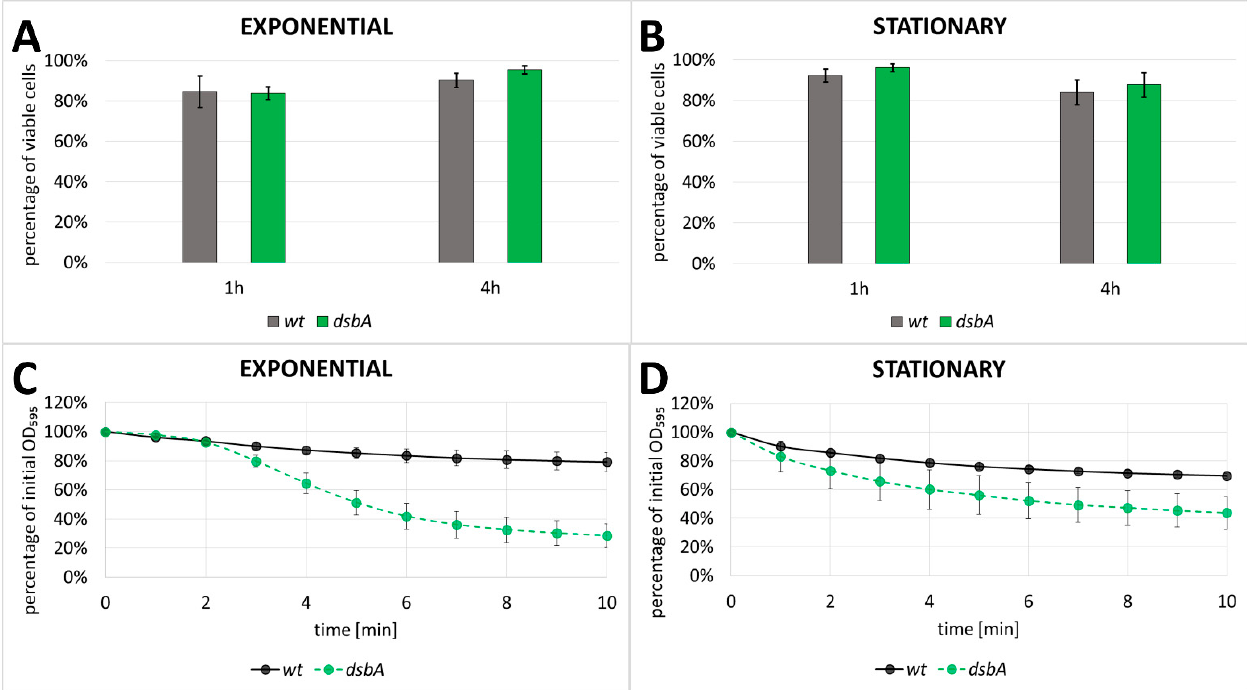
Figure 6. Analysis of membrane permeability using LIVE/DEAD fluorescence microscope assay ( A , B ) and sensitivity to SDS ( C , D ). The assays were conducted in exponential ( A , C ) and stationary ( B , D ) growth phases (wt—wild-type strain; dsbA —mutant strain, TP02). In LIVE/DEAD assay, data obtained from three independent biological replicates with at least three technical replicates per sample were analyzed. In the SDS sensitivity assay, the error bars represent SD from five independent biological replicates in two independent experiments ( n =